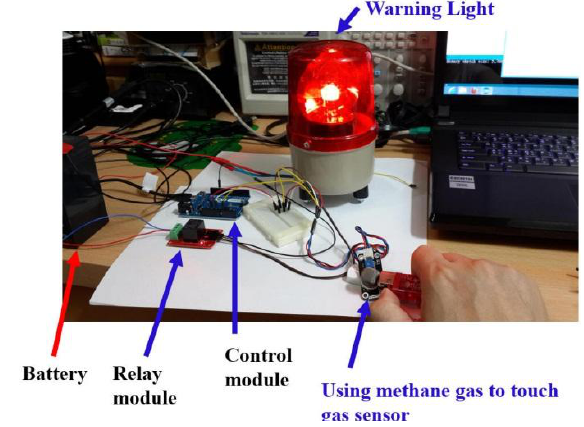
Figure 26. Experiments carried out with